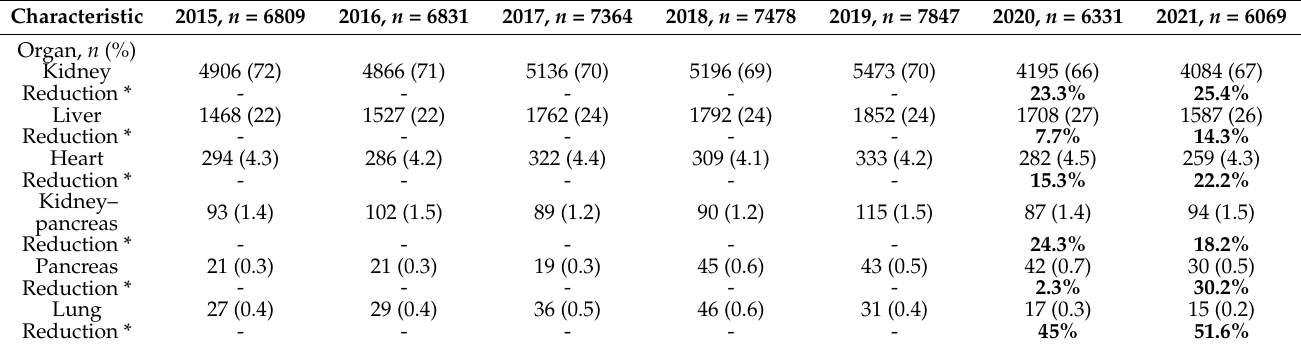
Table 1. Total number of solid organ transplants performed in Brazil’s Unified Healthcare System (SUS) from 2015 to 2021.